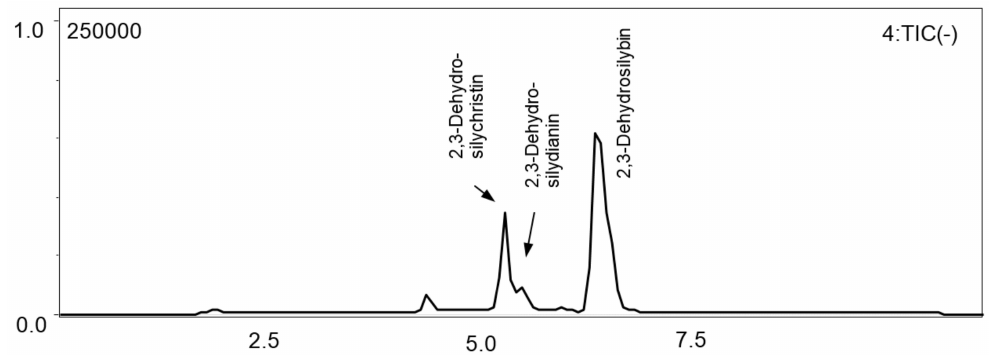
Figure 3. Quantification of 2,3-dehydroflavonolignans by LC-MS with mobile phase A = 5% acetonitrile, 0.1% formic acid, B = 80% acetonitrile, 0.1% formic acid, and gradient: 0 min 20% B, 5 min 90% B, 6 min 90% B, 8–10 min 20% B; flow rate 0.4 mL / min, 25 ◦ C, ESI-MS detection in negative mode at 479.0–479.1 m / z